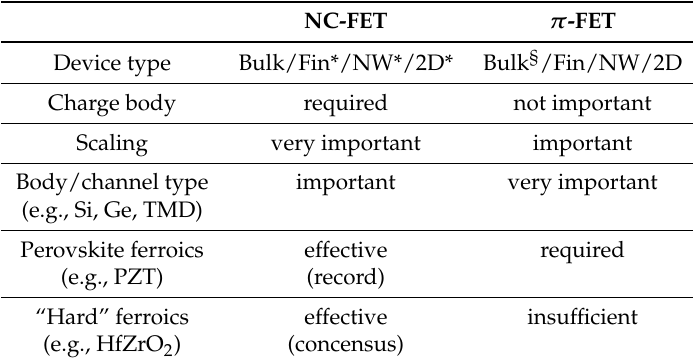
Table 3. A summary of the device architecture requirements for the NC-FET and π -FET. * Charge required in the close vicinity of the body, § May be less